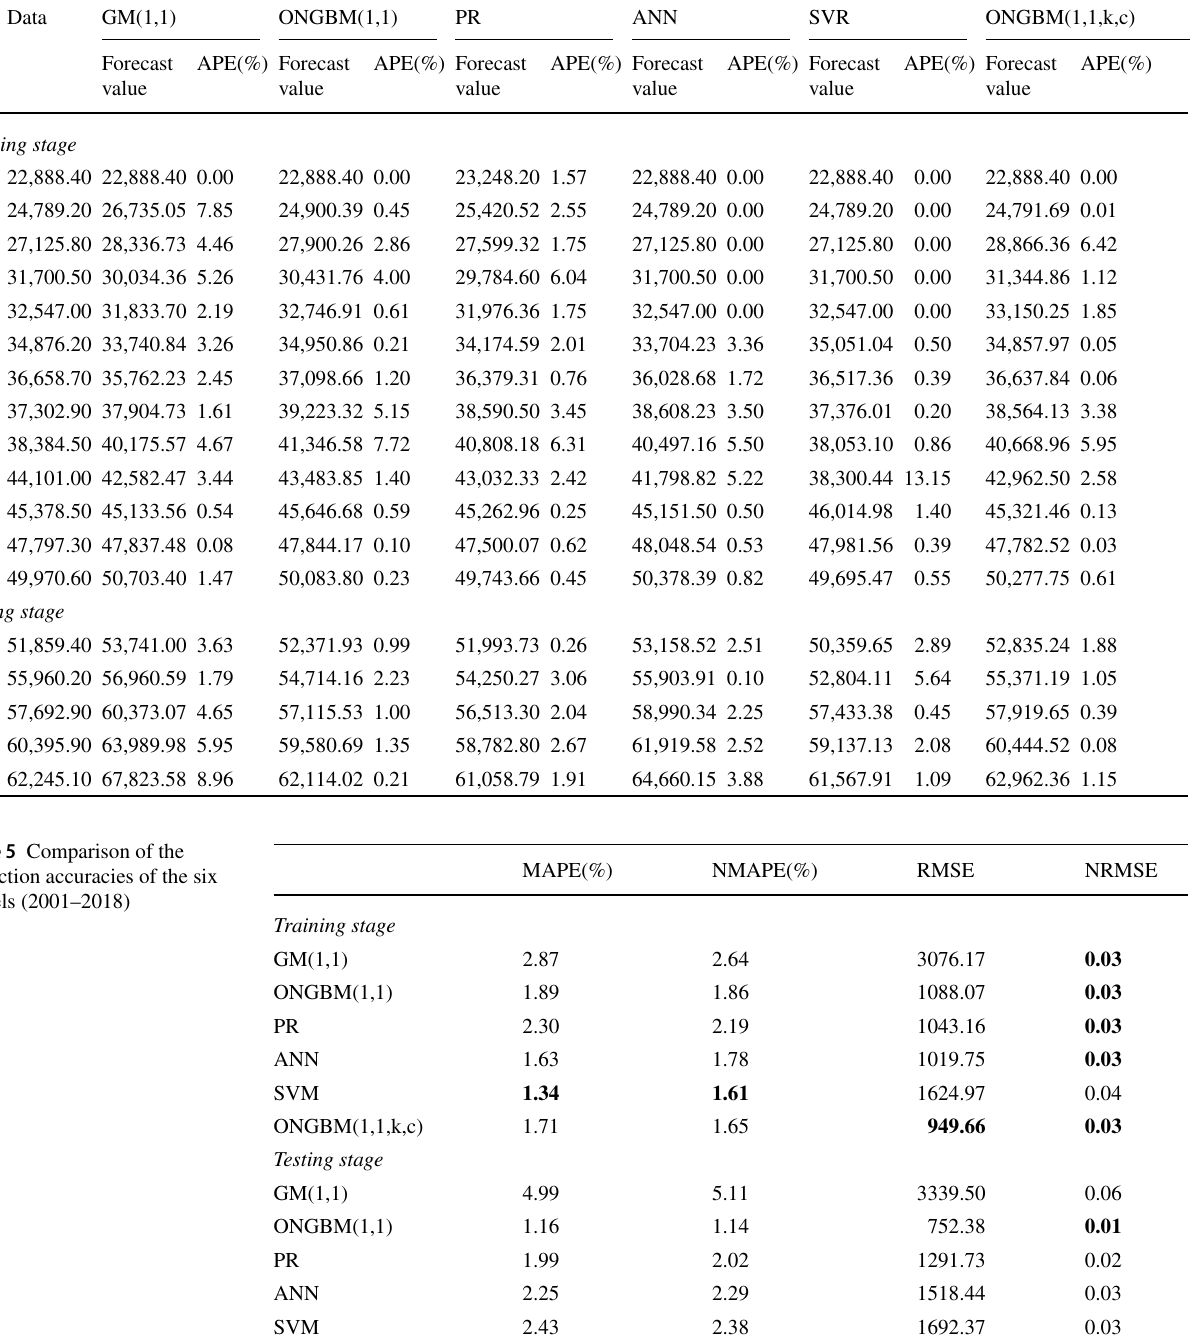
Table 4 Simulated and forecasted values of China’s petroleum consumption using different models Year Data